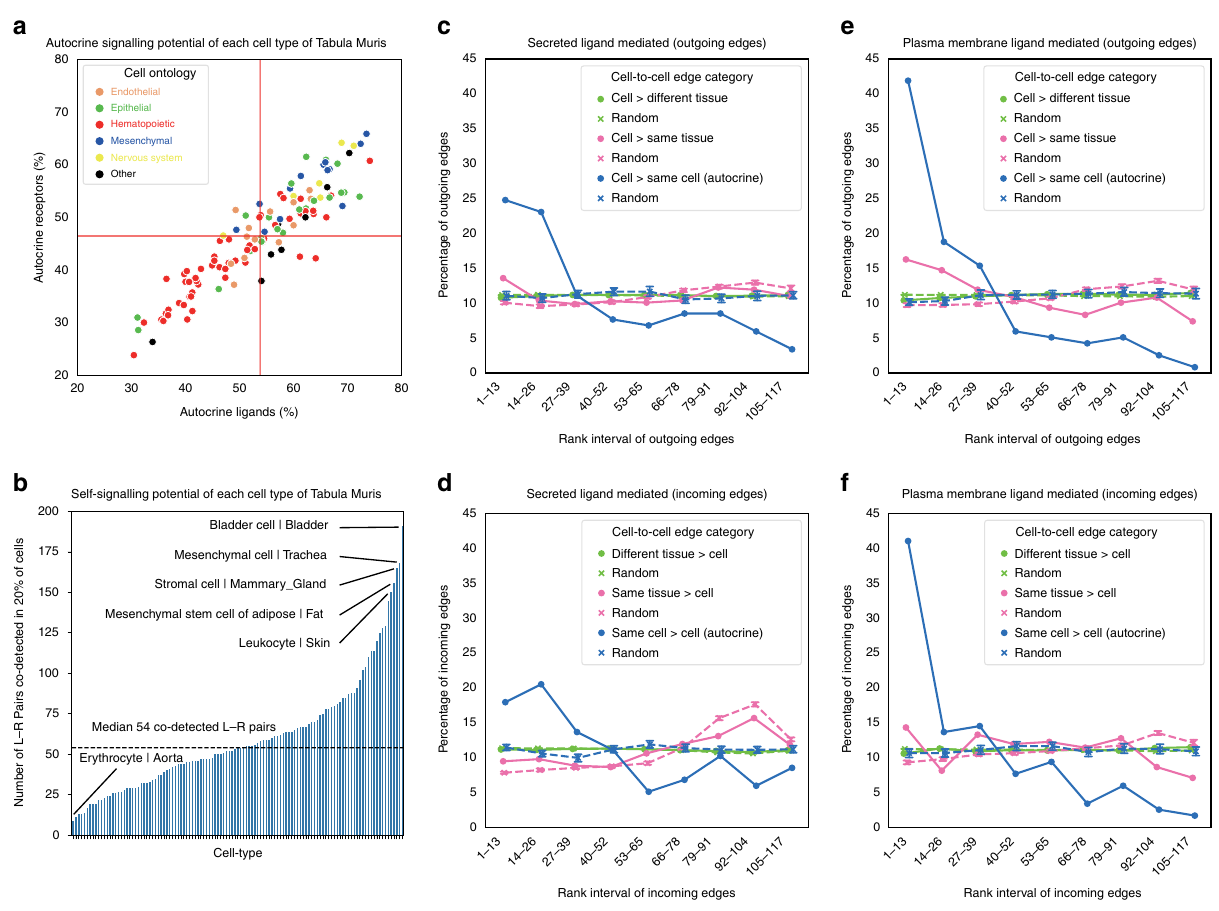
Fig. 4 Autocrine and self-signalling potential in Tabula Muris. NATMI was run across the 117 cell types identi fi ed in the Tabula Muris dataset (at the detection rate threshold of 20%). a Autocrine signalling potential of each cell type in Tabula Muris. Each point corresponds to a cell type, and colours indicate broad lineage classes. X -axis shows the fraction of ligands expressed by a given cell type where the cognate receptor is also expressed in the same cell type. Y -axis shows the reciprocal for the fraction of receptors on a given cell type where the cognate ligand is also expressed. Red lines show the mean fractions of ligands and receptors. b Self-signalling potential of each cell type in Tabula Muris. The dashed line indicates the median number of ligand – receptor pairs co-detected in more than 20% of cells of each cell type (at 10CPM threshold). In c – f , cell-to-cell pairs are classi fi ed as autocrine (blue), intra-organ (pink), and inter-organ (green) summary edges. The summary edges are then ranked by summed speci fi city and the distribution of ranks for each of the three classes shown. Error bars represent standard deviation of ranks. c The distribution of ranks of secreted ligand mediated outgoing edges. d The distribution of ranks of secreted ligand mediated incoming edges. e The distribution of ranks of plasma-membrane ligand mediated outgoing edges. f The distribution of ranks of plasma-membrane ligand mediated incoming edges. The average distributions of autocrine, intra-organ and inter-organ edges through 100× randomised ligand – receptor pairs are shown as dashed